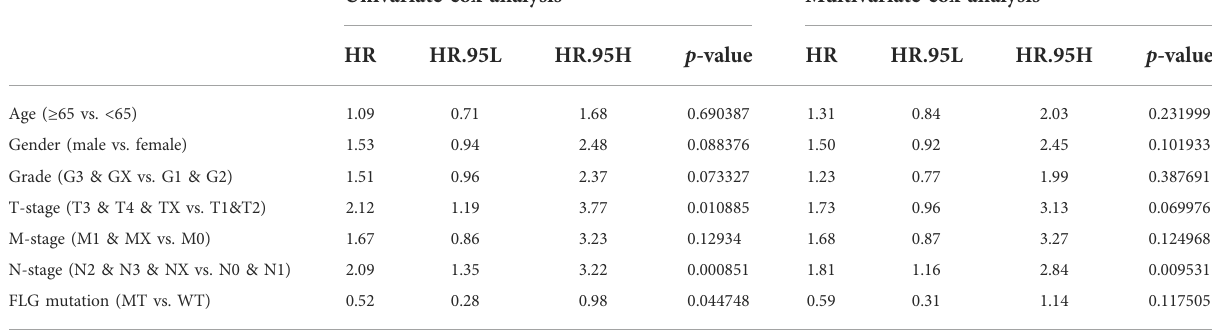
TABLE 3 Univariate and multivariate analyses with the Cox proportional hazards regression model based on FLG gene mutation for predicting DFS in TCGA